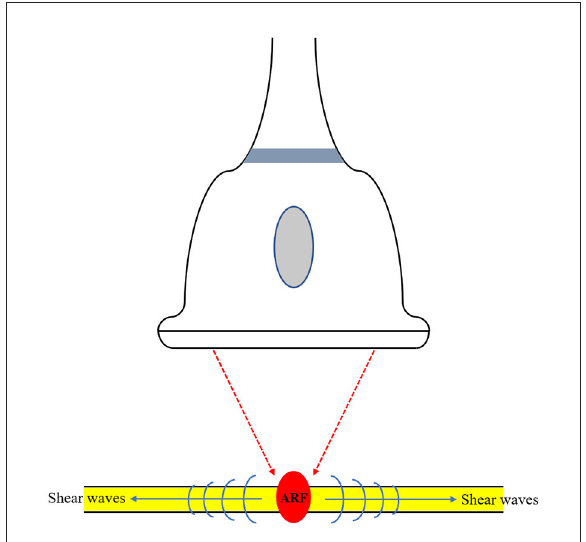
FIGURE3 Illustration of the shear wave elastography (SWE) technique used in examination of nerves. SWE generates shear waves via acoustic radiation force (ARF). This technique provides more quantitative information in relation to the elasticity of the tissue.